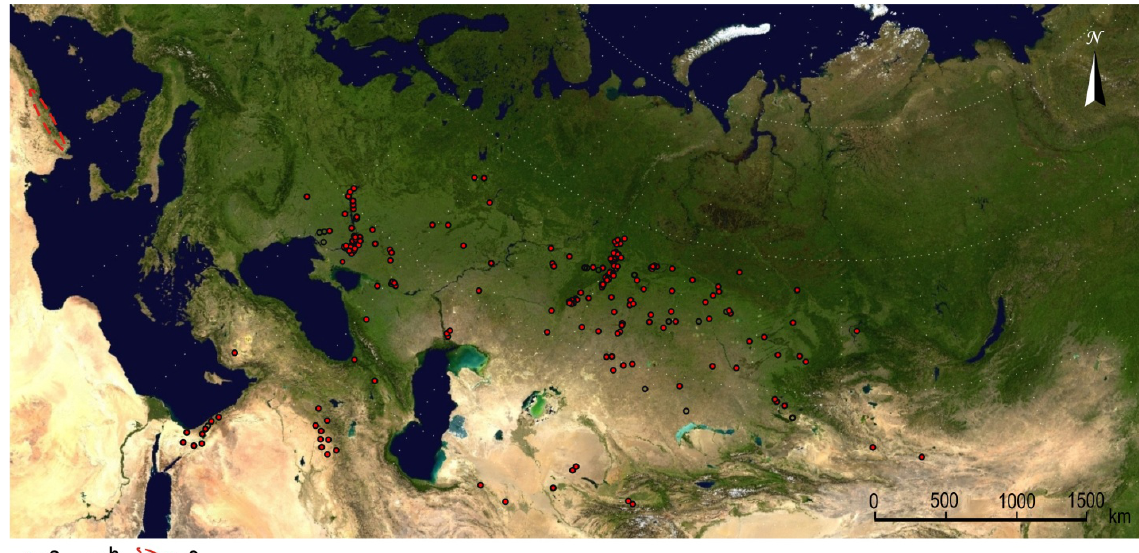
Figure 4. Distribution of transverse grooved artefacts: a. sites with TGA; b. precise location of find unknown; c. distribution of TGA mentioned in the literature without precise data on location. (A composite satellite photograph of Asia in orthographic projection from NASA PD; TGA sites data from Usacheva (2013a: 188-